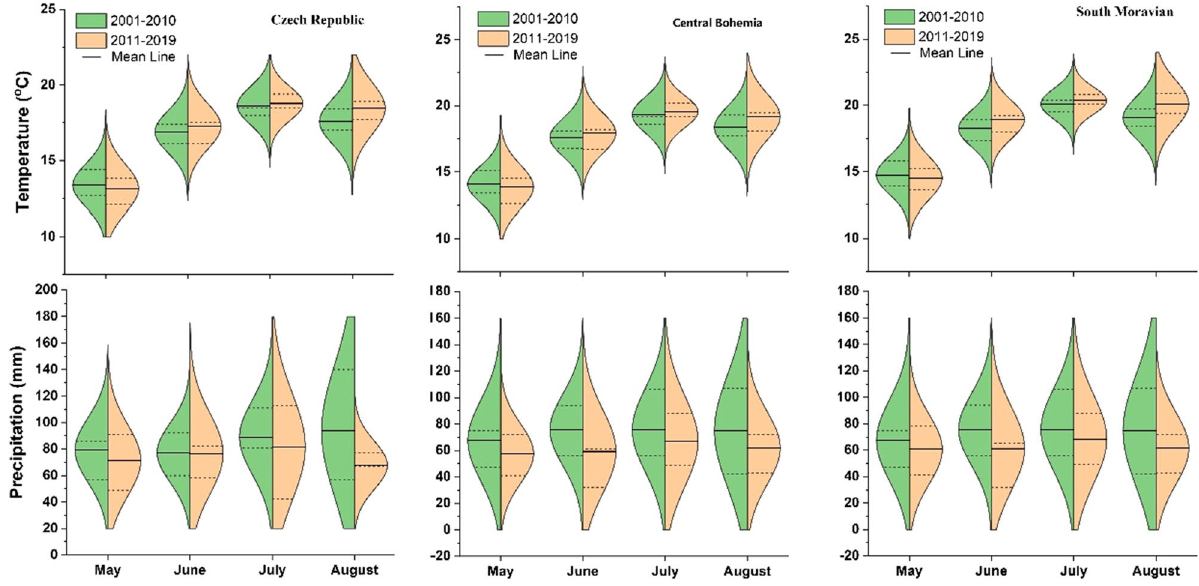
Figure 4. Precipitation and temperature of the maize growing season in the 2000s and 2010s in the Czech Republic, Central Bohemia, and South Moravian. The split violin plot shows both the distribution of the data and its summary statistics (mean/median and interquartile ranges).